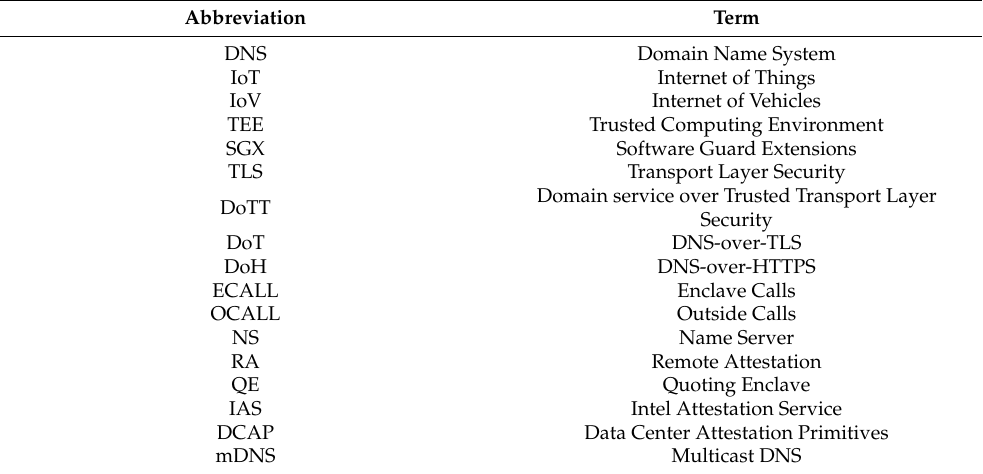
Table 2. The list of abbreviations used in this